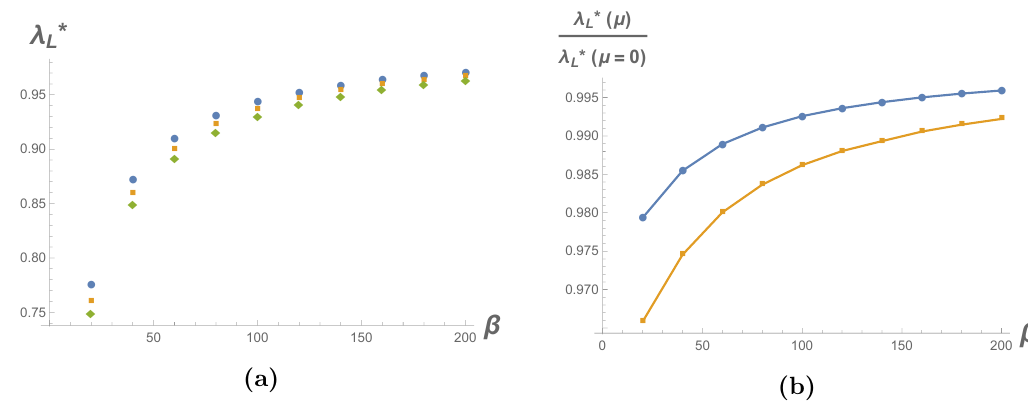
Figure 8. (a) The Lyapunov exponent for di(cid:11)erent (cid:12)xed (cid:22) = 0 ; 0 : 18 ; 0 : 22 as a function of the inverse temperature (cid:12) . (b) The ratio of the Lyapunov exponent for non-zero (cid:22) and for (cid:22) = 0. The ratio converges to 1. This shows that the upper bound of the Lyapunov exponent is still 2 (cid:25)=(cid:12) even with non-zero chemical potential.